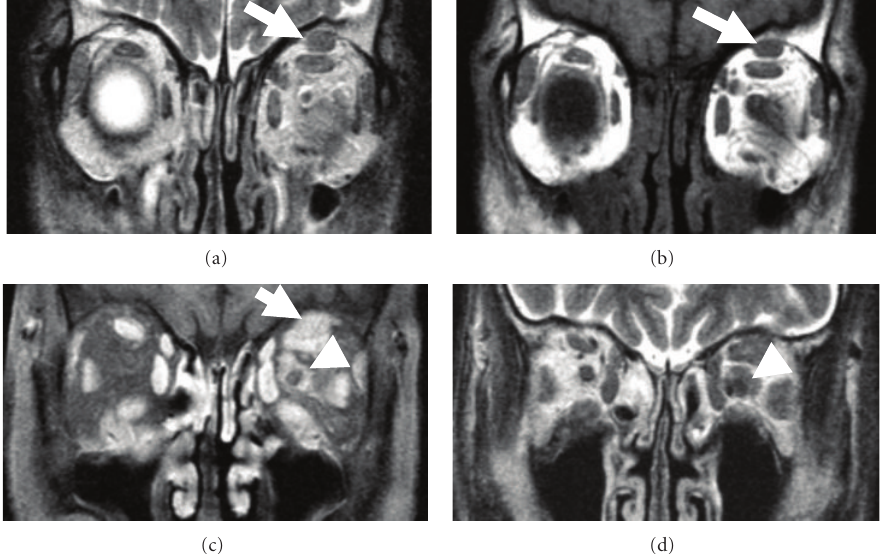
Figure 3: MRI ((a and d): T2-weighted images; b: T1-weighted image; c: contrast-enhanced T1-weighted image) of orbital space in 61-year- old man (case 3). MRI shows the soft tissue around the left supraorbital nerve (a–c; arrows) and optic nerve (c and d; arrowheads). The left optic nerve can be detected in the